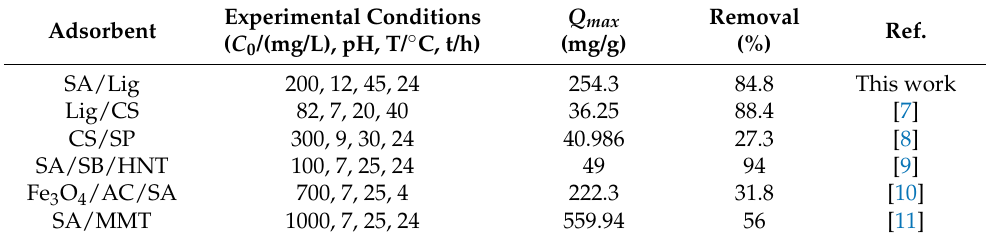
Table 3. Comparison of the MB removal performance with similar adsorbents.